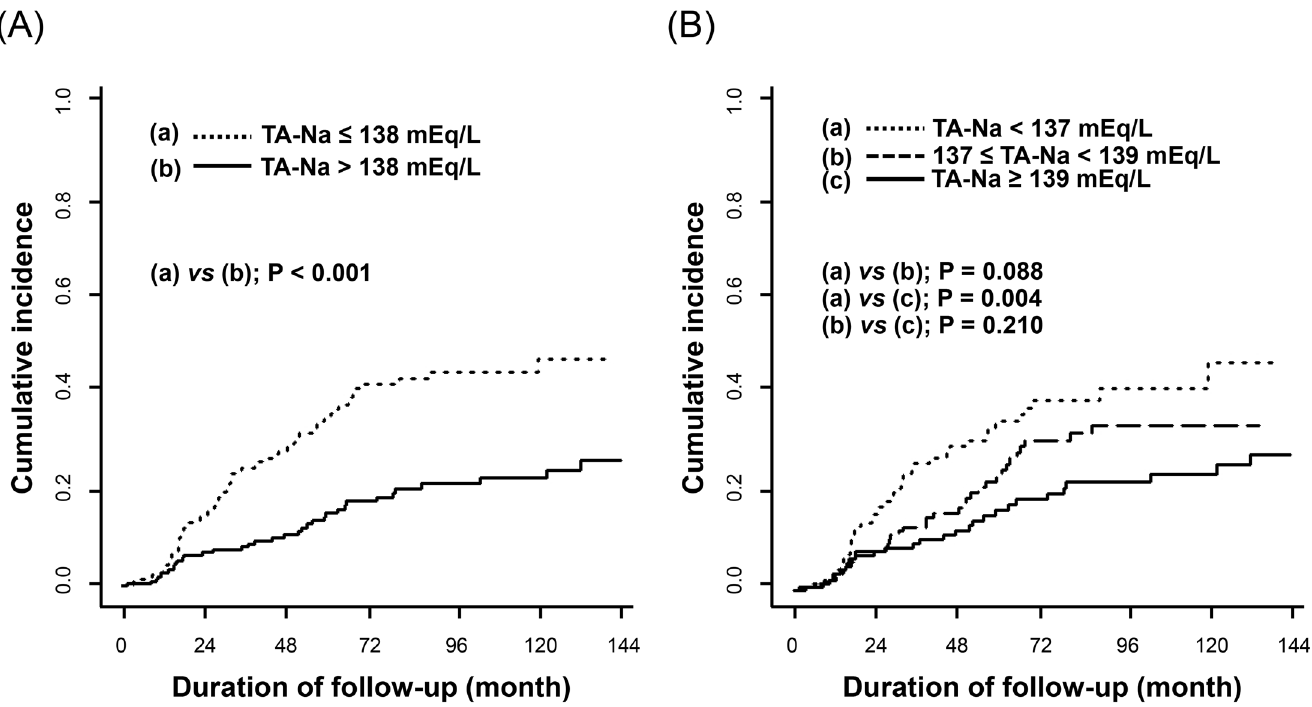
Fig 1. The cumulative incidence curves for the first occurrence of a cardiovascular event after the initiation of peritoneal dialysis between groups defined according to the median (A) and tertile (B) of the time-averaged serum sodium (TA-Na)